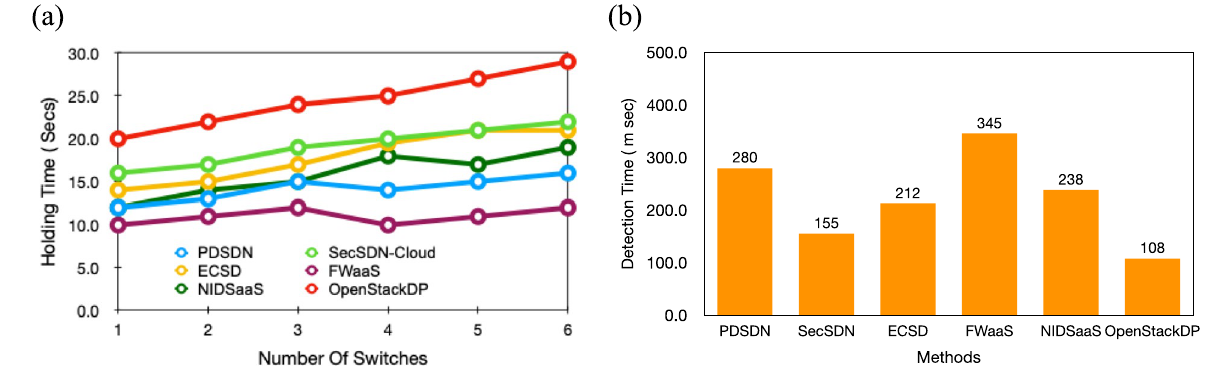
Fig. 29 a Holding Time in Flow tables, b Detection